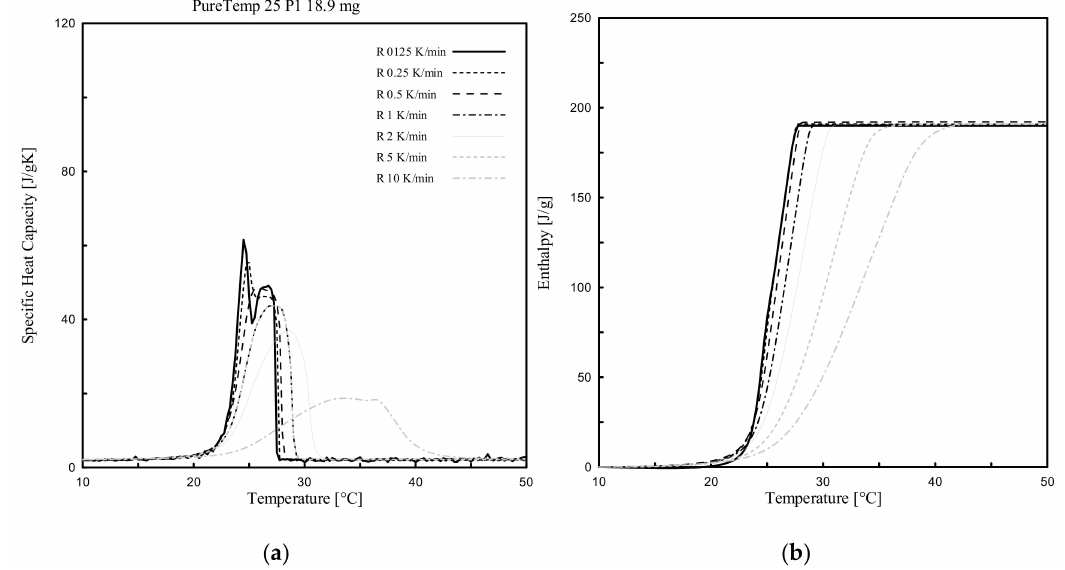
Figure 8. Dynamic DSC measurements: ( a ) c p (T) and ( b ) h(T) curves (latent only) with di ff erent heating rates for